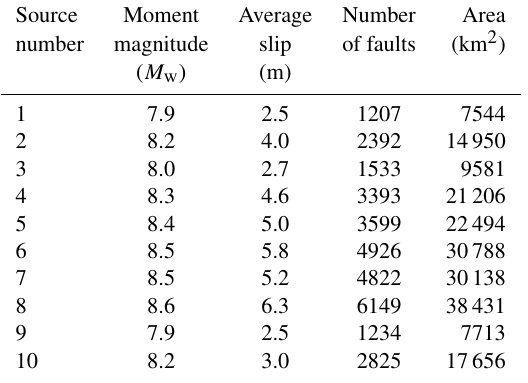
Table 2. Moment magnitude, average slip, number of faults, and area in each earthquake source of the Sagami Trough